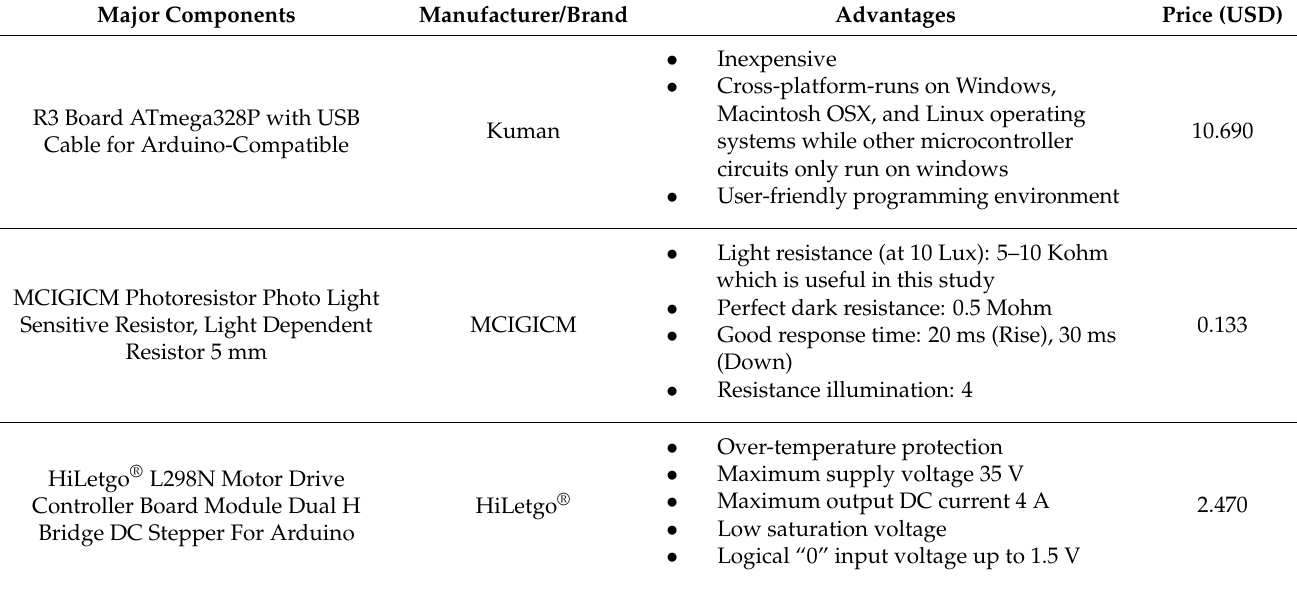
Table 1. List of all components that were used to fabricate the automated hand sanitizer dispenser. Major Components Manufacturer/Brand